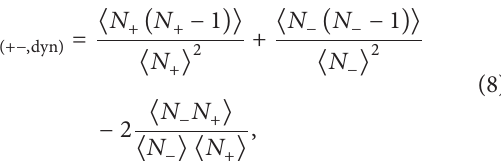
Figure 3: Centrality dependence of the scaled variance in Au + Au collisions for 0.2 < 𝑝 𝑇 < 2.0 GeV/ 𝑐 for √𝑠 𝑁𝑁 = 62.4 and 200 GeV [30]. Results from the superposition model are overladed with the shaded regions representing a one-standard deviation range of the prediction for the fluctuation magnitude derived from p + p collision data. Contributions from noncorrelated particle emission with the Poisson distribution of the scaled variance with the addition of elliptic flow in 200 GeV Au + Au collisions are also shown.